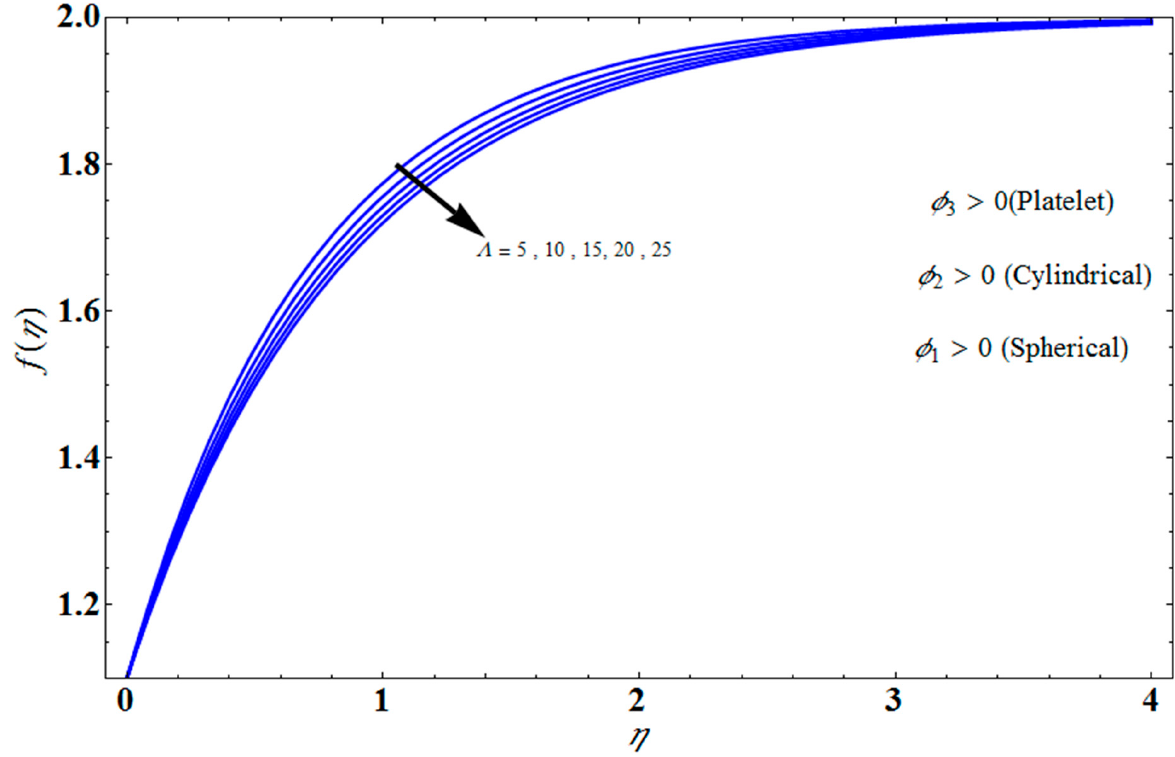
( ) f η on η for several values of Λ . Figure 5. Influence of f ( η ) on η for several values of Λ